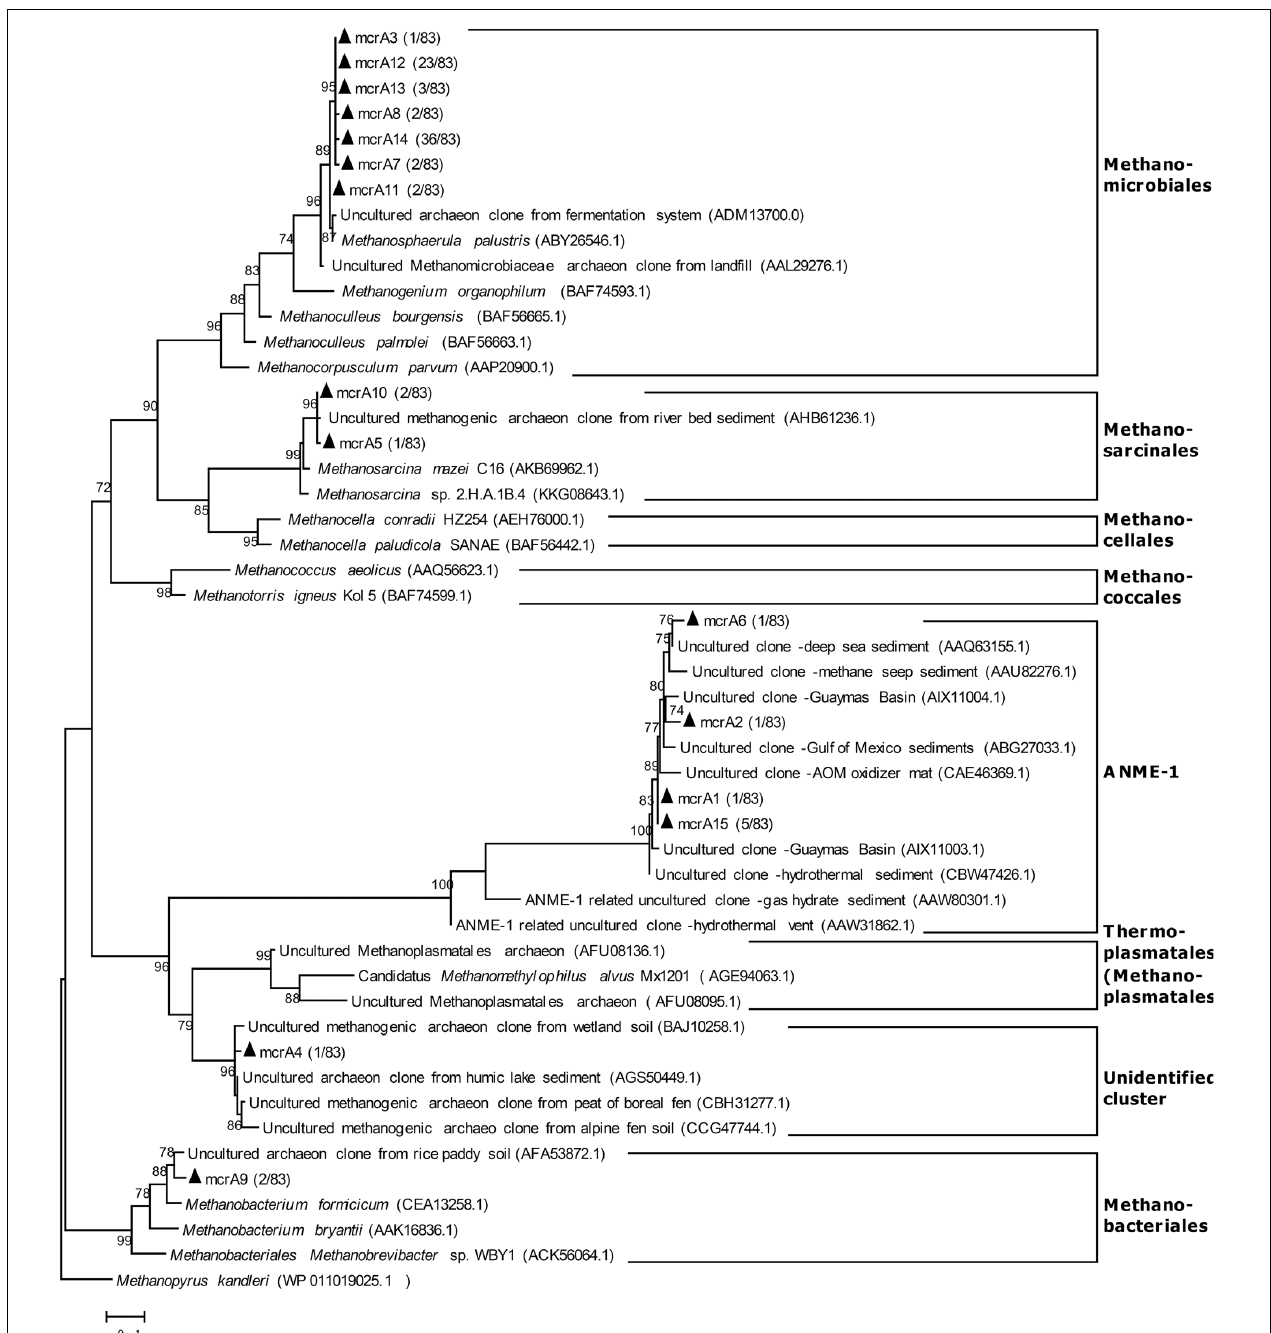
FIGURE 3 | Phylogenetic tree based on translated partial amino acid sequences of the mcrA gene from raw Antarctic subglacial sediment. The sequences from this study and reference sequences were aligned with ClustalW in MEGA 6.0. The tree was constructed with FastTree (Version 2.1.3, ML Model: Jones–Taylor–Thorton) and visualized with MEGA 6.0. The scale bar represents a difference of 0.1 substitutions per site. The mcrA gene sequences marked with black triangles were derived from this study. The number in parentheses indicates the clone